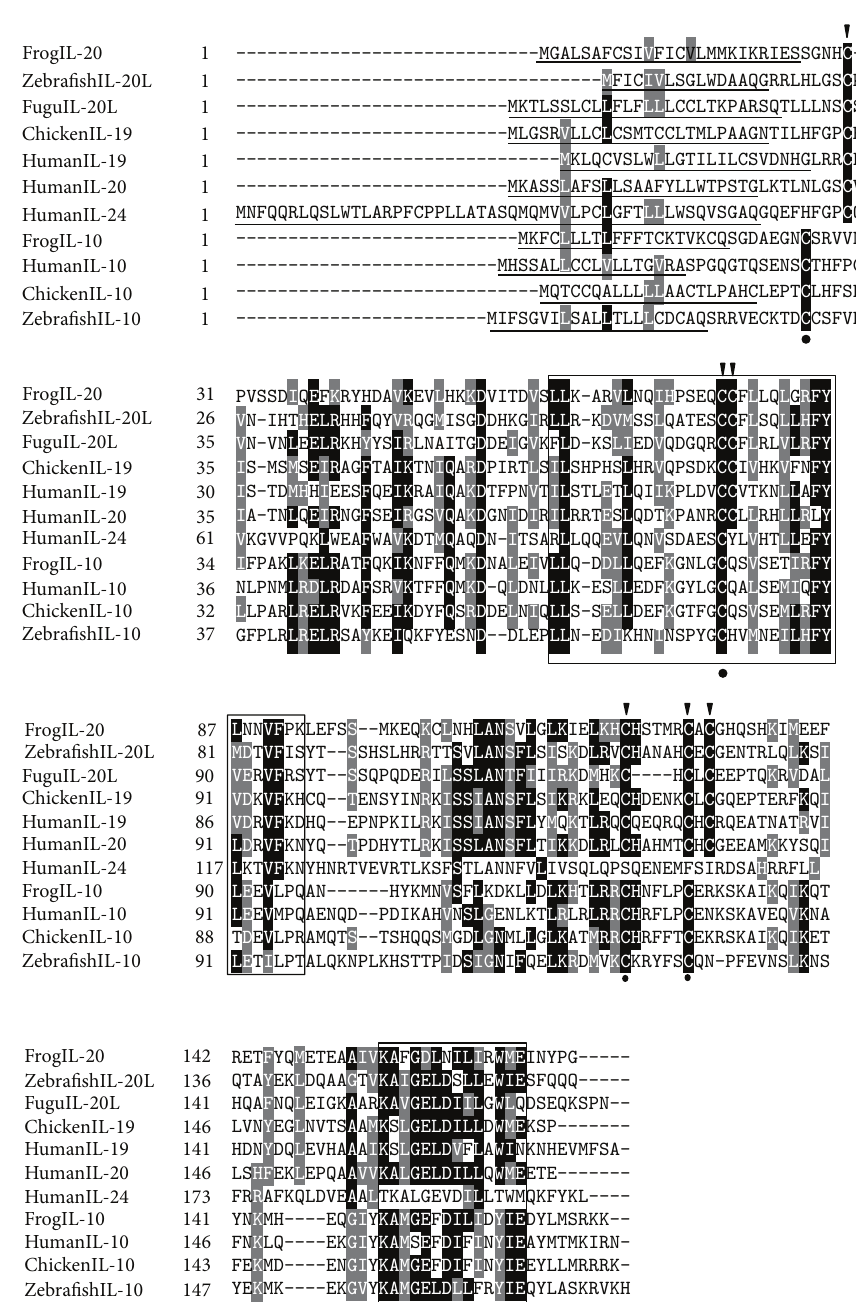
Figure 2: Multiple alignment of vertebrate IL-10. The multiple alignment was produced using Clustal W, and conserved amino acids were shaded using GeneDoc software. The signal peptides predicted by SignalP 4.1 server were underlined. The conserved IL-10 family signature motifs were boxed. The four conserved cysteine residues existing in IL-10 were indicated by black cycles below the alignment and the six conserved cysteine residues in IL-19/20 were indicated by black arrows above the alignment. The accession numbers for sequence used in this alignment were listed in Figure